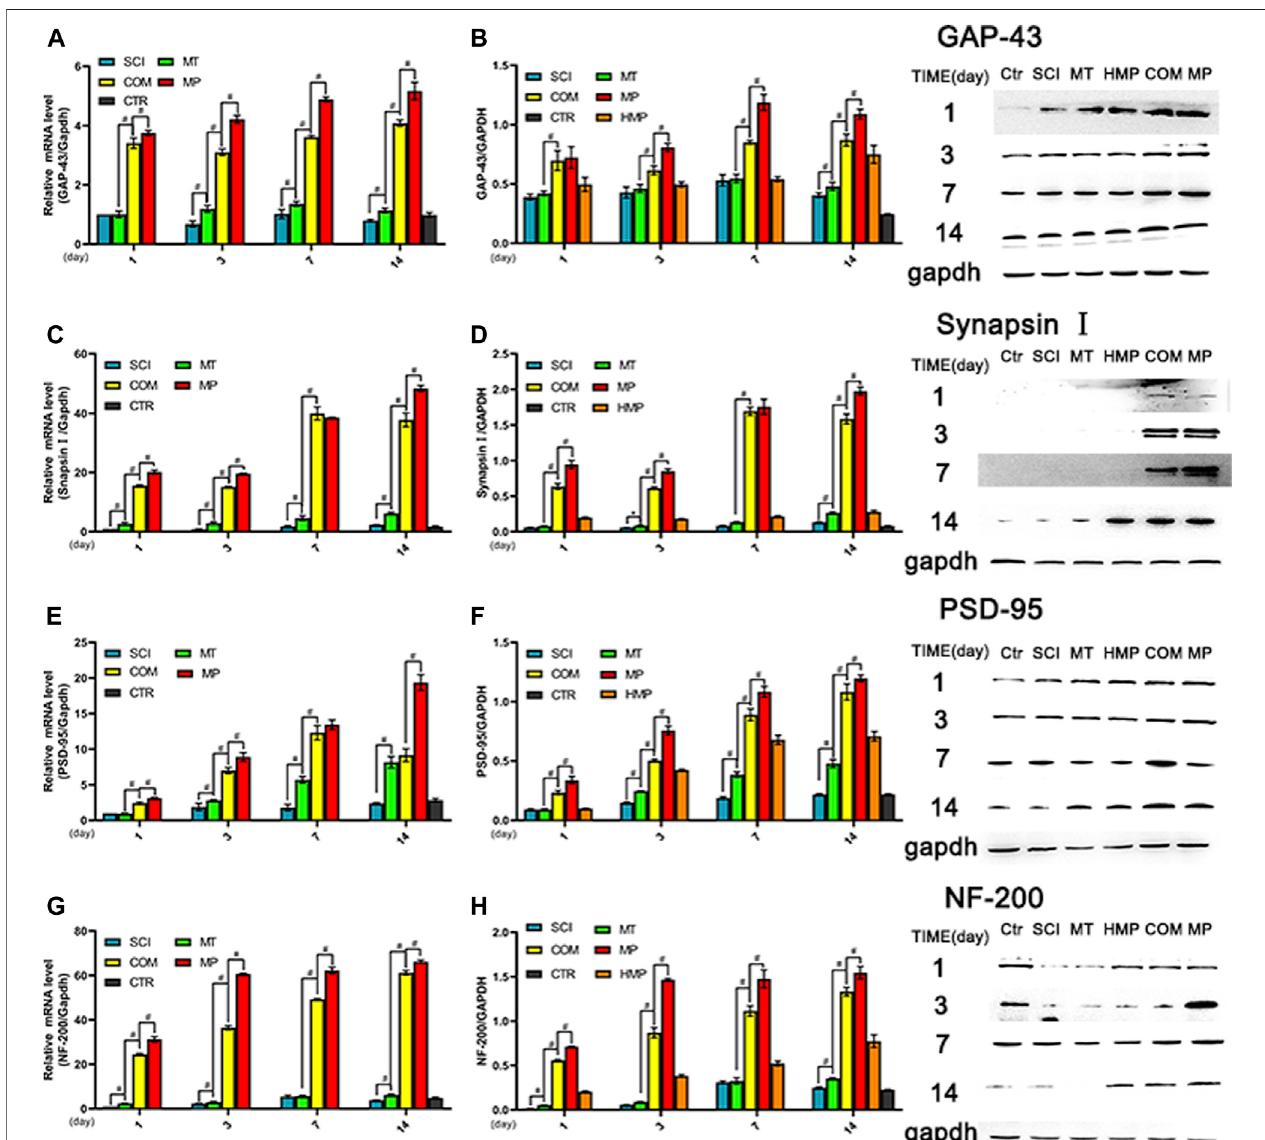
FIGURE 4 | The mRNA and protein levels of key axon related proteins in rats with SCI. (A, B) . The relative expression levels of GAP-43 mRNA and protein ( n (cid:1) 3); (C, D) .Therelativeexpression levels ofsynapsinImRNAand protein ( n (cid:1) 3); (E, F) . Therelative expression levels ofPSD-95mRNA andprotein ( n (cid:1) 3). G, H.Therelative expression levels of NF-200 mRNA and protein ( n (cid:1) 3), on the 1st, 3rd, 7th, and 14th days post-injury. * p < 0.05, # p < 0.01. GAPDH was used as the control. Quanti fi cationoftheseresultswasperformedbyscanningdensitometry.Errorbarsrepresentthestandarddeviation.CTRgroupresultisaverageofthe4sampling time